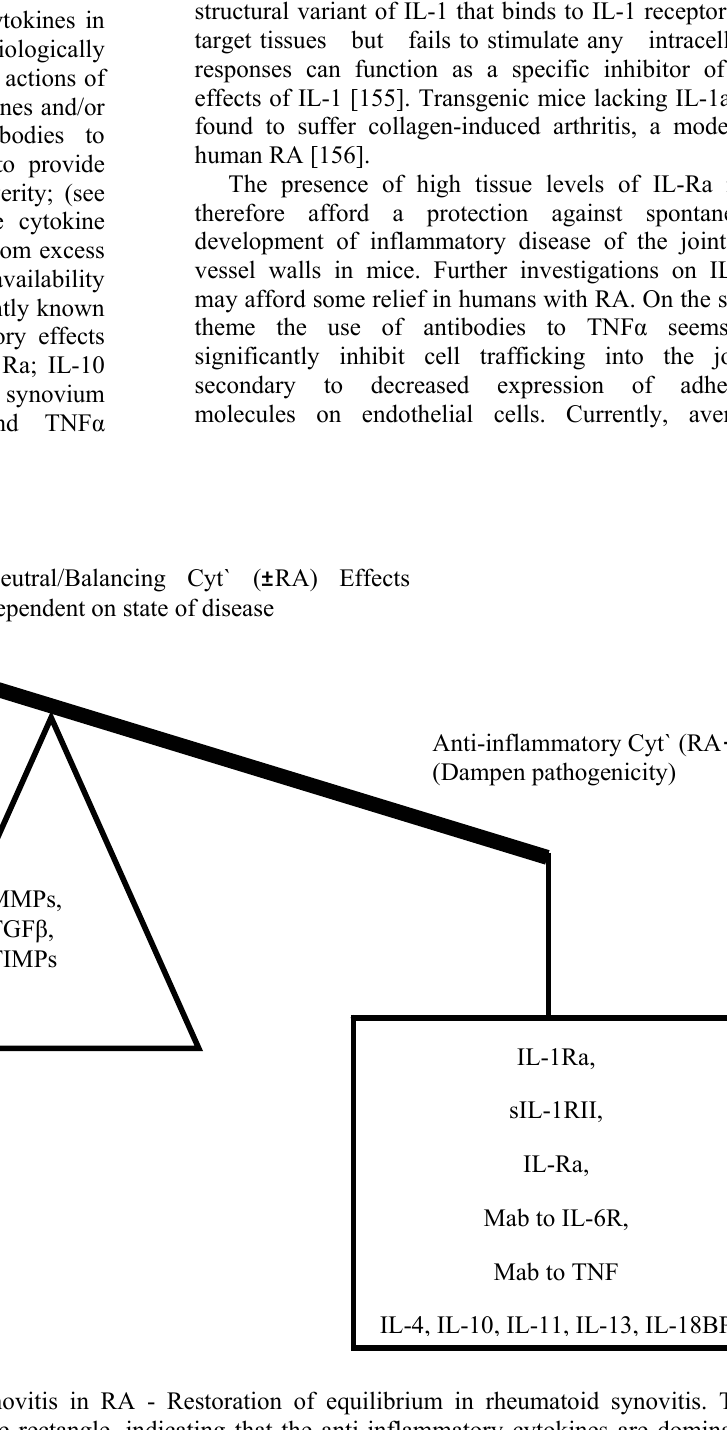
Figure 4 : Equilibrations in Rheumatoid Synovitis in RA - Restoration of equilibrium in rheumatoid synovitis. The balance is shifted to the right with out of size rectangle, indicating that the anti-inflammatory cytokines are dominant. GM-CSF, granulocyte-macrophage colony-stimulating factor; IFN, interferon; IL, interleukin; IL-Ra, interleukin –1 receptor antagonist; TGF, transforming growth factor; TNF, tumor necrosis factor. Cyt`- cytokine